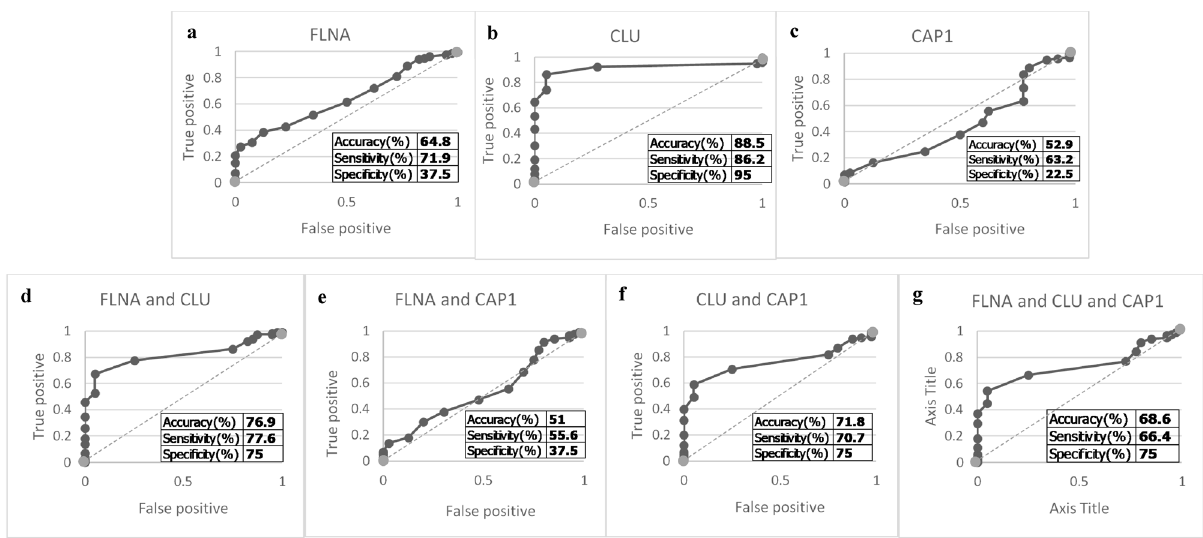
Figure 4. The ROC graph and the result of accuracy, sensitivity, specificity in each combination including; ( a) FLNA, ( b) CLU, ( c) CAP1, ( d) FLNA and CLU, ( e) FLNA and CAP1, ( f) CLU and CAP1, ( g) FLNA and CLU and CAP1.This analysis use samples from the hepatic fibrosis group and the non-alcoholic fatty liver group as a